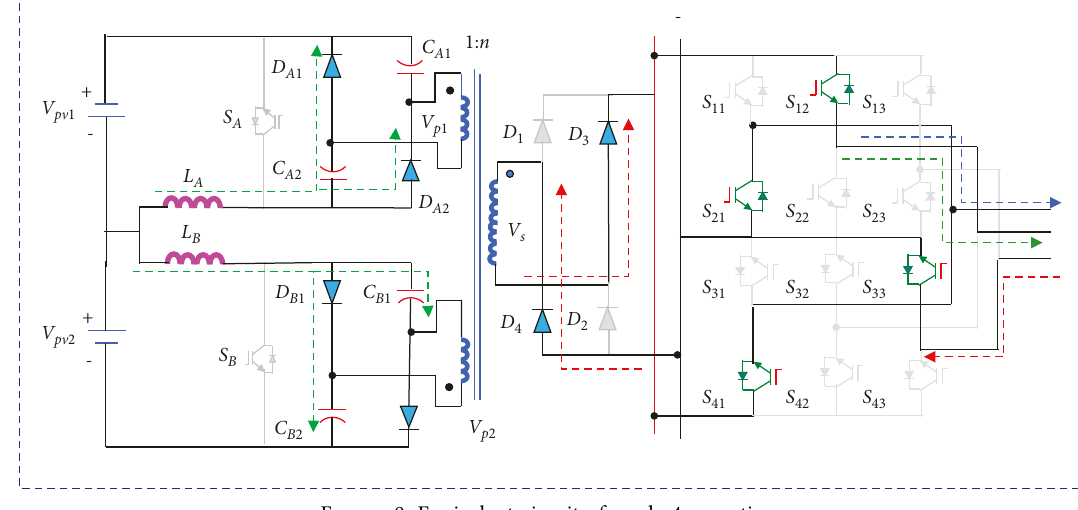
Figure 8: Equivalent circuit of mode 4 operation.